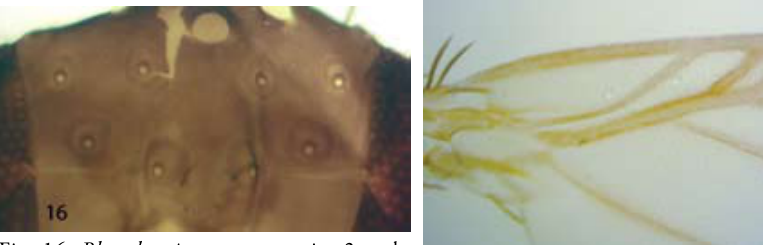
Fig. 16. Rhynchomicropteron species 2 male, frons.